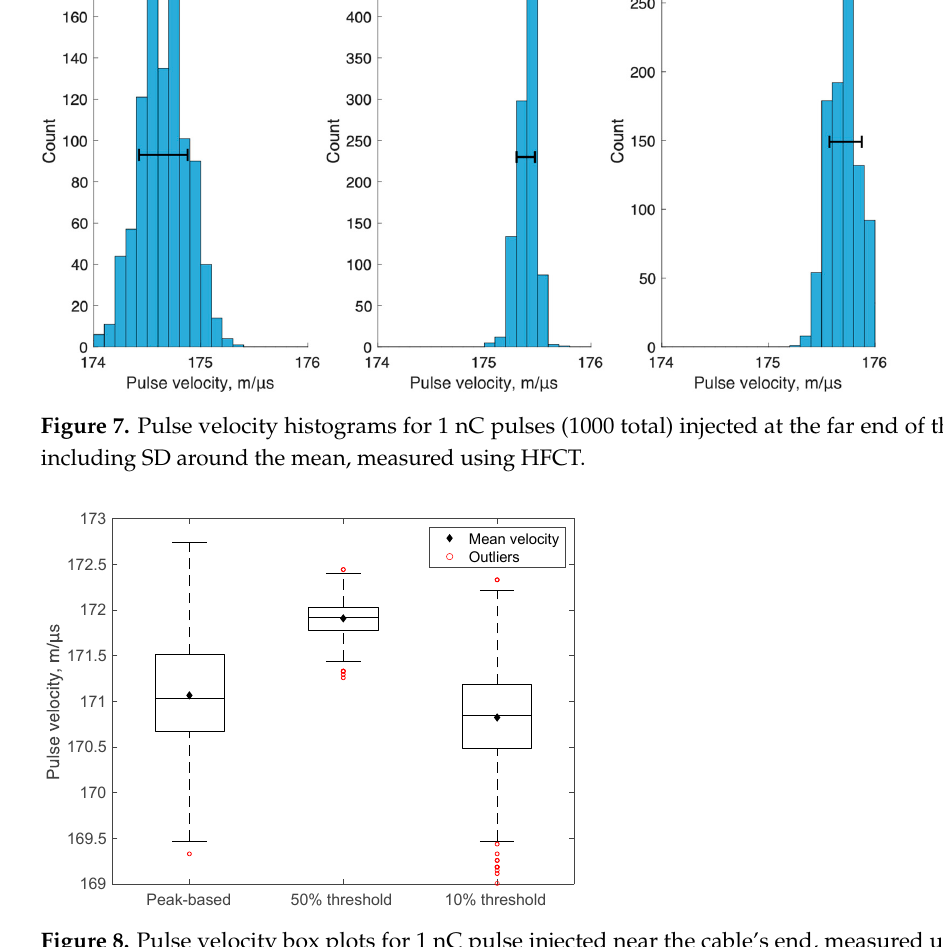
Figure 8. Pulse velocity box plots for 1 nC pulse injected near the cable’s end, measured using the IEC 60270-compliant system.